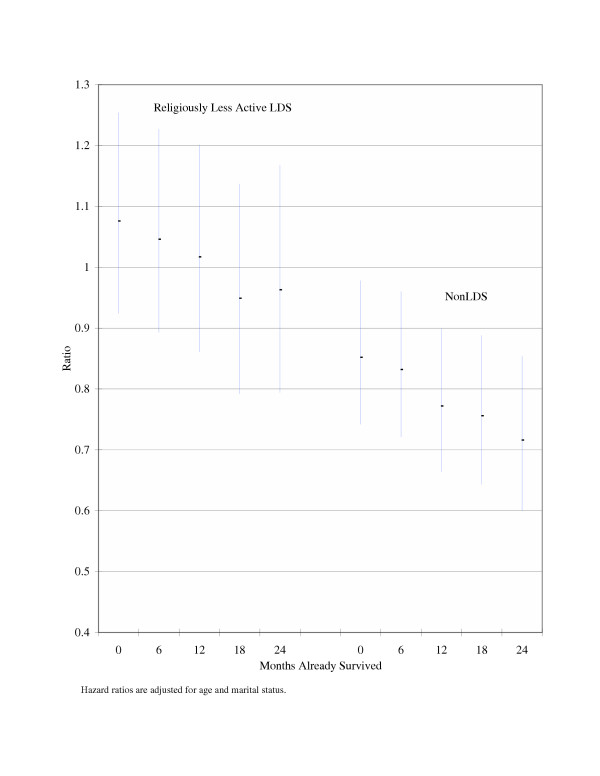
Hazard ratios (95% confidence intervals) of death from breast cancer for religiously less active LDS and non-LDS compared with religiously active LDS conditioned on having already survived x months